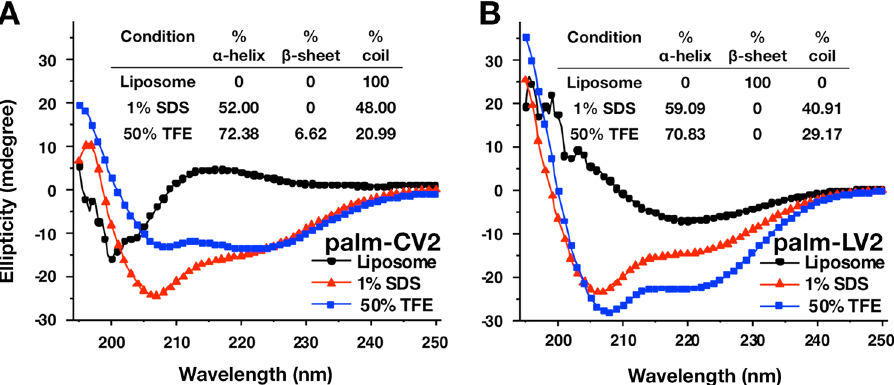
Fig. 3 CD spectra. Palm-CV2 (3A) and palm-LV2 (3B) were examined under different experimental conditions. The traces represent an average of three